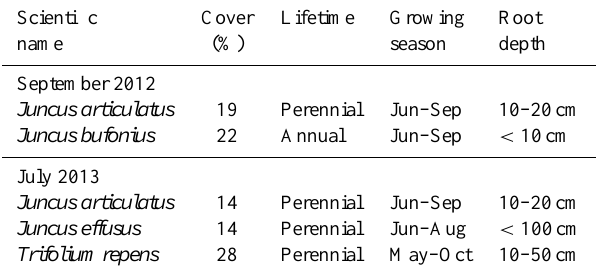
Table 3. Characteristics of the most dominant riparian vegetation species found in the floodplain, including average cover (%), life- time, growing season and maximum root depth. The presented char- acteristics were obtained from http://www.wilde-planten.nl/ ( Wilde planten in Nederland en België – Wild plants in the Netherlands and